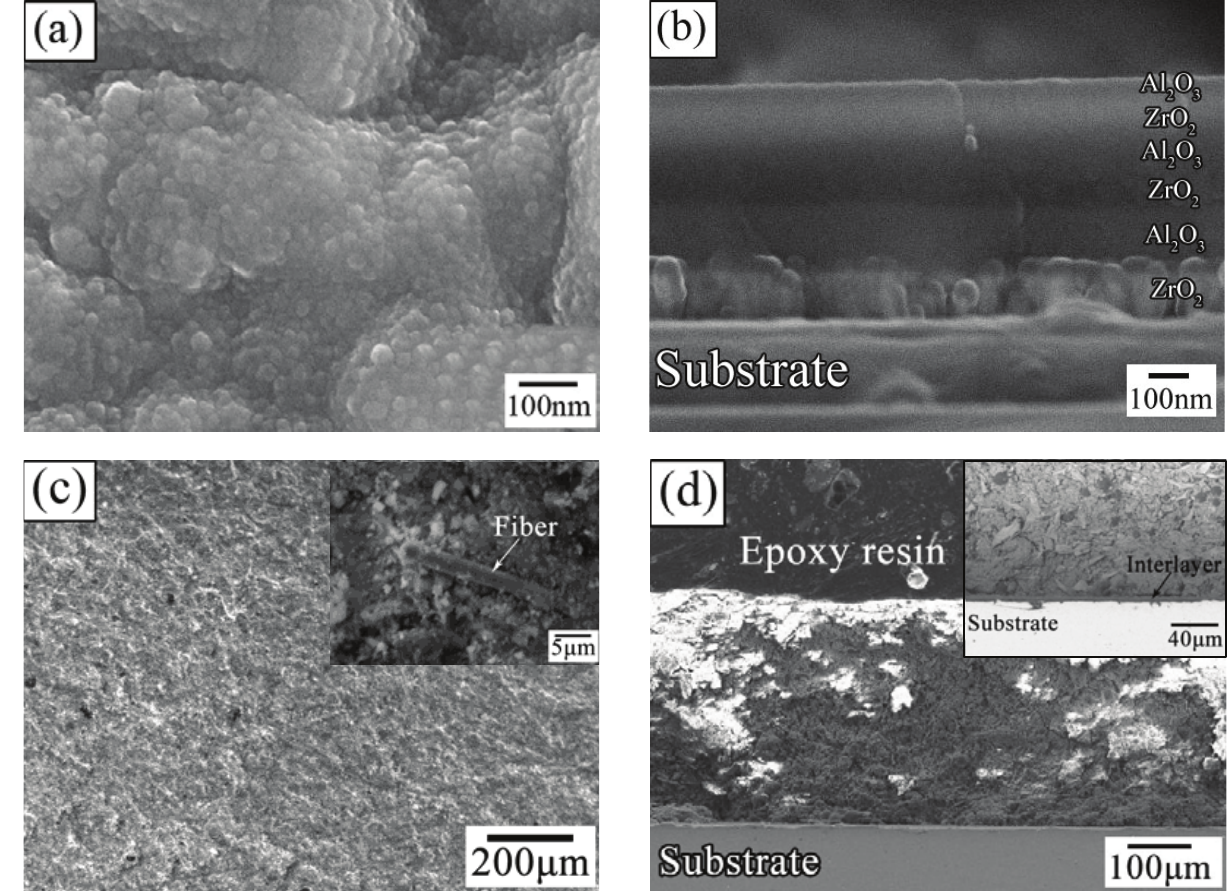
Figure 1. Surface (a) (c) and cross-section (b) (d) morphologies of micro-laminated ZrO 2 /Al 2 O 3 coatings and fiber- reinforced TBCs with ZrO 2 /Al 2 O 3 interlayers.